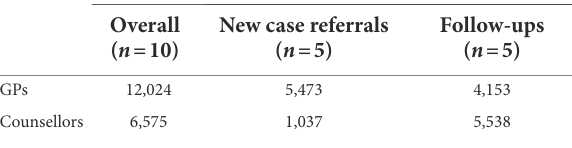
TABLE 1 The amounts of talk in the GP–counsellor interactions. The amounts of total talk (nos. of words)